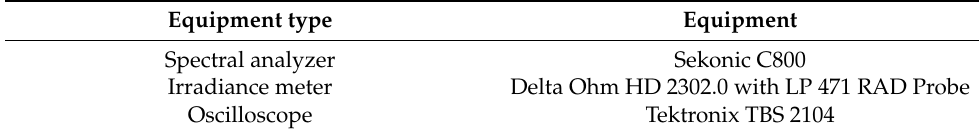
Table 6. Equipment used during the tests.